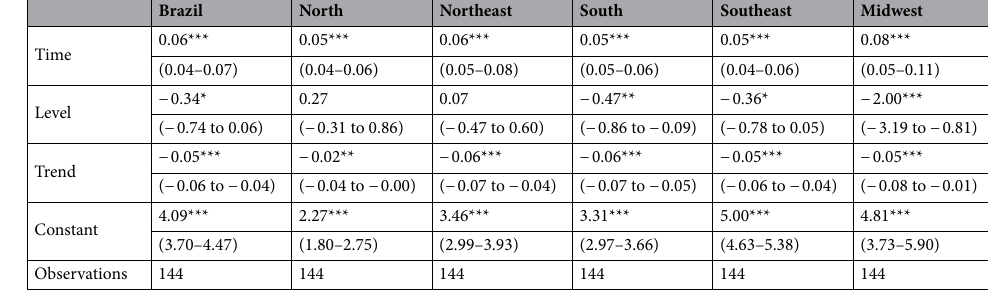
Table 4. Results from the interrupted time series regression for Brazil and regions, 2008–2019. 95% CI in parentheses. *** p < 0.01, ** p < 0.05, * p < 0.1.